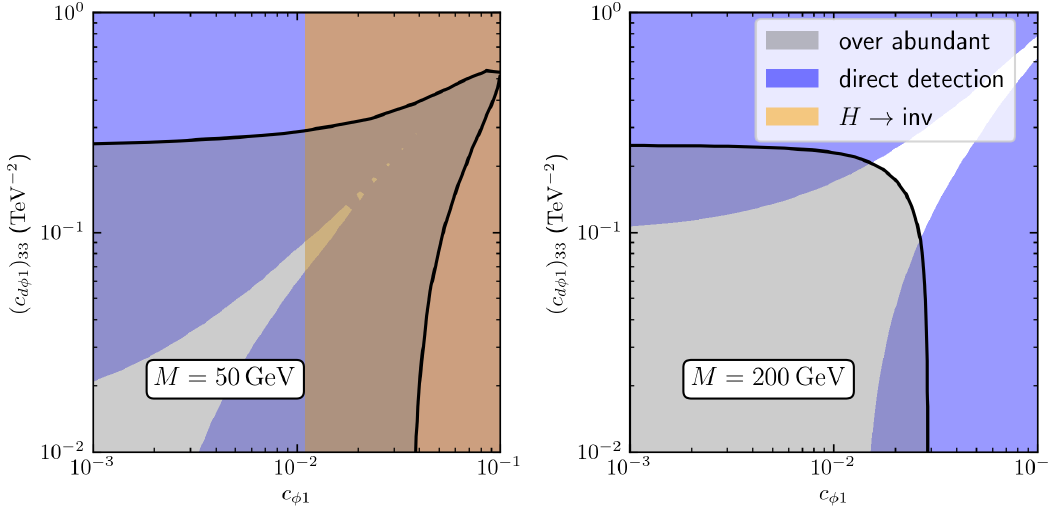
Figure 3 . Line of points (in black) that give the correct DM abundance, together with the region that gives an overabundance of DM (in gray), the region excluded by direct-detection experiments (in blue) and the region excluded by the upper bound on BR( H → inv ) (in orange), in the space of c vs. c , for different values of M dφ 1 φ 1 ϕ